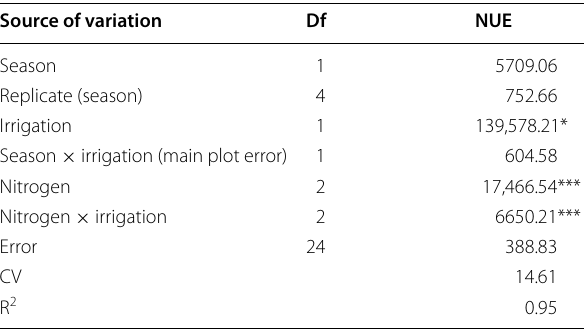
Table. 9 Mean squares of